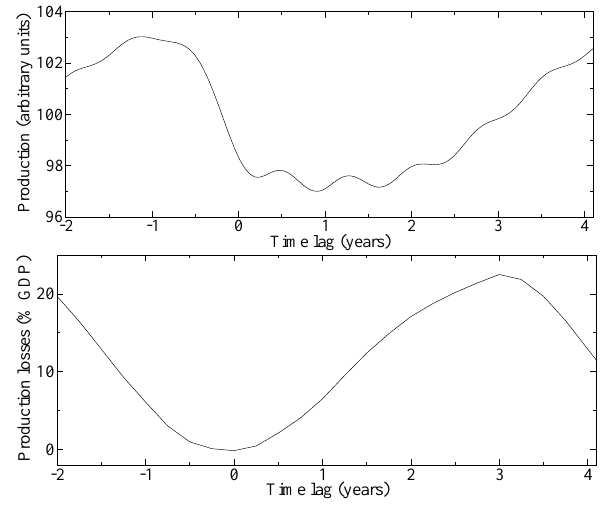
Fig.13. Theeffectofonenaturaldisasterontheendogenousbusinesscycle(EnBC)oftheNEDyMmodelin Fig. 13. The effect of one natural disaster on the endogenous busi- Fig.12. Toppanel: thebusinesscycleintermsofannualgrowthrate(inarbitraryunits),plottedasafunction of the time lag with respect to the cycle minimum; bottom panel: total GDP losses due to one disaster, as a ness cycle (EnBC) of the NEDyM model in Fig. 12. Top panel: the functionofwhentheyoccur,measuredasinthetoppanel. Adisasteroccurringatthecycleminimumcausesa business cycle in terms of annual growth rate (in arbitrary units), limitedproductionloss,whileadisasteroccurringduringtheexpansionleadtoamuchlargerproductionloss. plotted as a function of the time lag with respect to the cycle min- AfterHallegatteandGhil(2008). imum; bottom panel: total GDP losses due to one disaster, as a function of when they occur, measured as in the top panel. A dis- aster occurring at the cycle minimum causes a limited production loss, while a disaster occurring during the expansion lead to a much larger production loss. After Hallegatte and Ghil 100